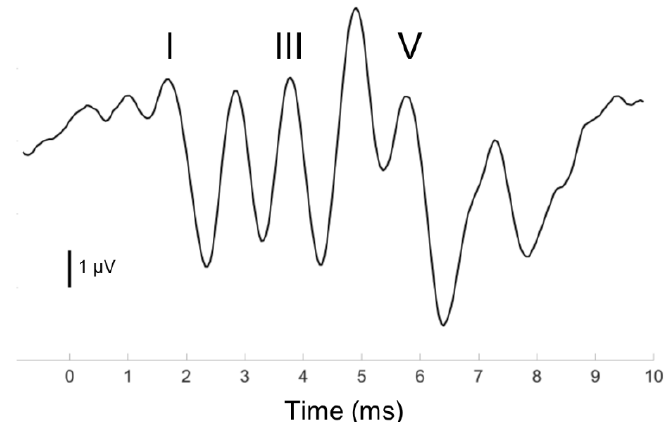
Figure 1. Representative Auditory Brainstem Response (ABR) evoked by a brief, click stimulus presented at 6.9/second with Waves I, III, and V labeled. Each wave is the result of synchronous neural firing from distinct neural populations in the subcortical auditory system.